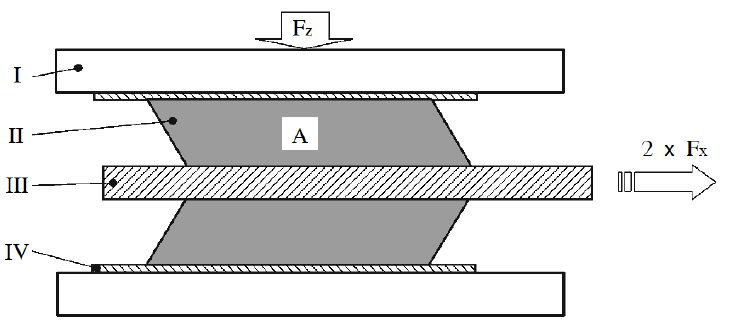
Figure 1. Shear modulus test conditions.